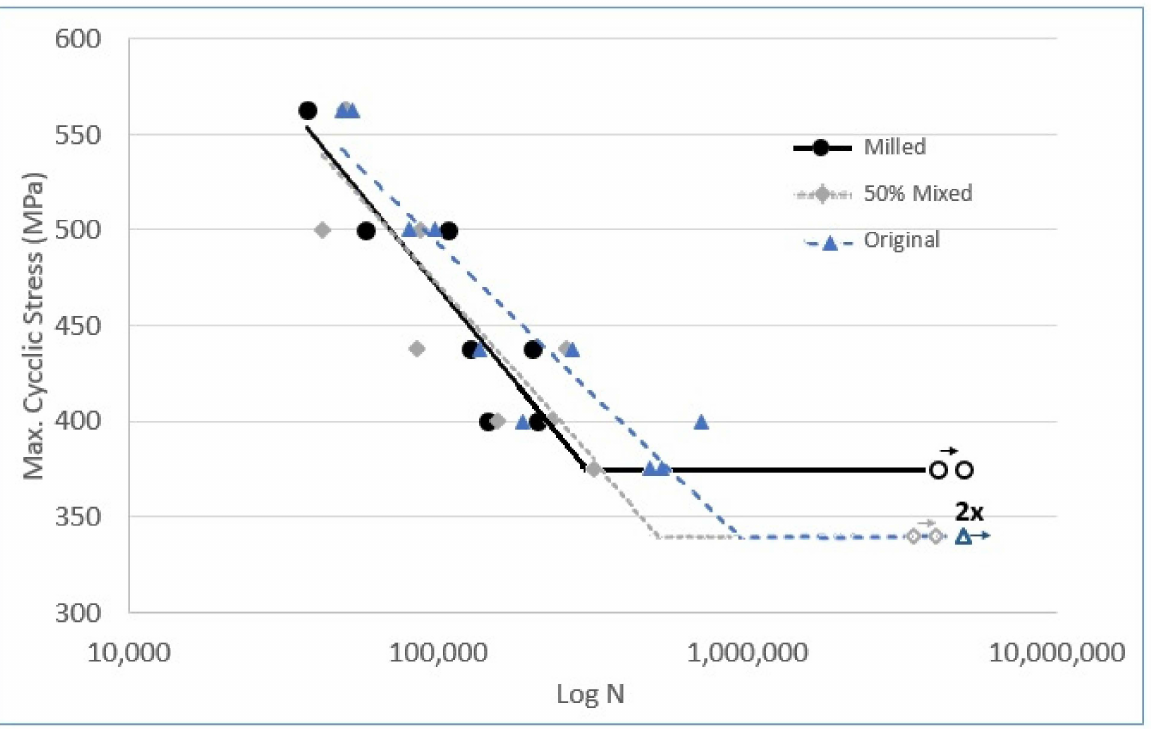
Figure 9. S-N curves of the coating produced from HEM-milled, original, and 50% mixed spray powder. The open dots represent specimens that did not fracture during the fatigue test.